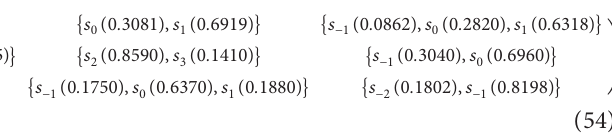
Table 4: The individual consensus degree ICL ( l )